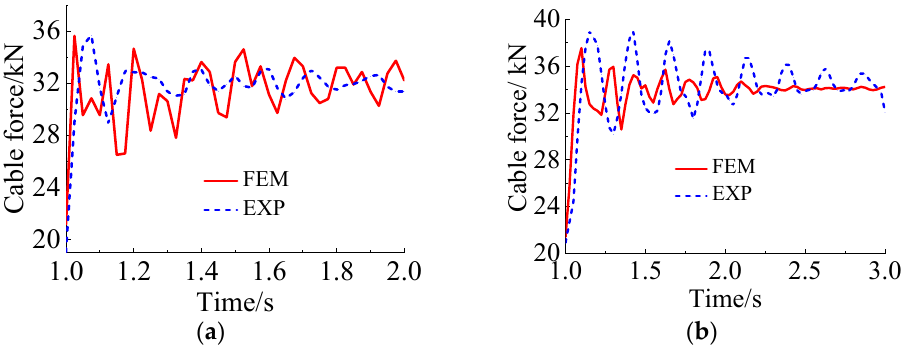
Figure 15. The time history plots of the suspender force due to the breakage of long and short suspenders: ( a ) 1# suspender broken; ( b ) 6# suspender broken.